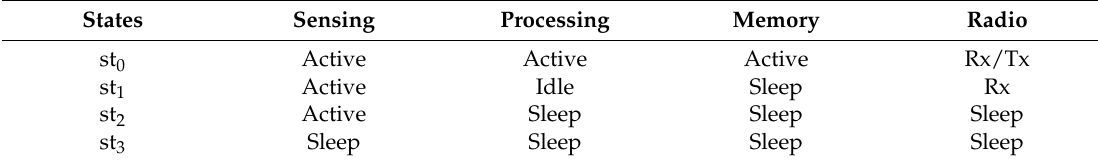
Table 1. Useful sleep states for sensor node. Table 2. Sleep states of multi-mode sensed